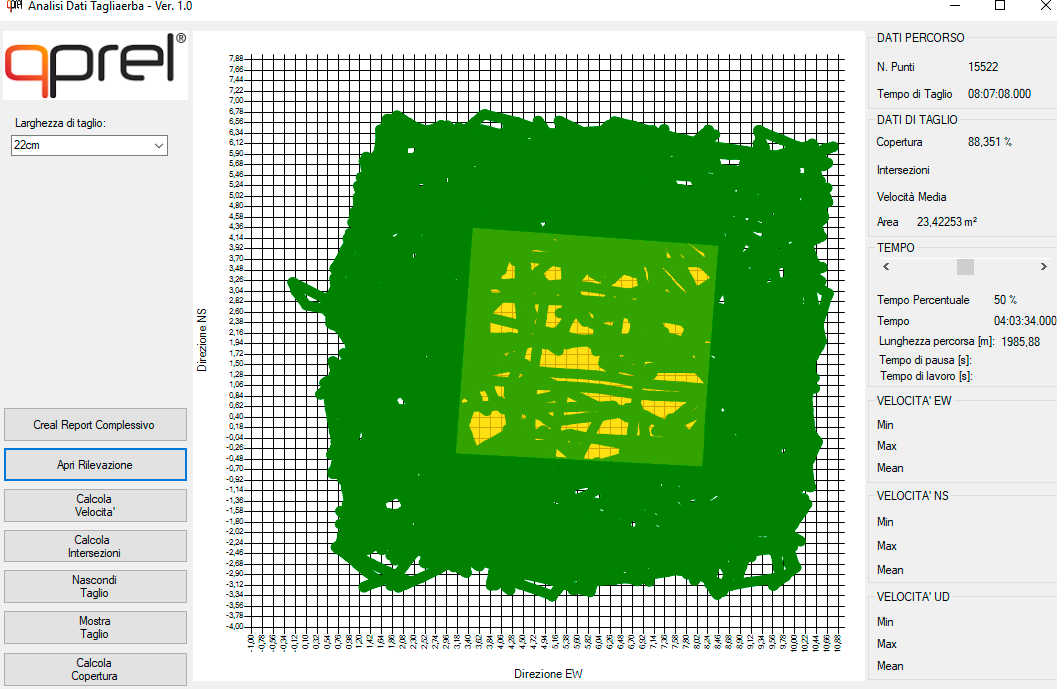
Figure 2. Custom-built software “Robot mower tracking data calculator” showing the percentages of turfgrass mown by the autonomous mowers Medium 1 (green lines) at 50% of the working time on Site B (on 12 February 2019). The yellow area is the area with obstacles (extension: 23.04 m 2 ). Agronomy 2020 , 10 , x FOR PEER REVIEW